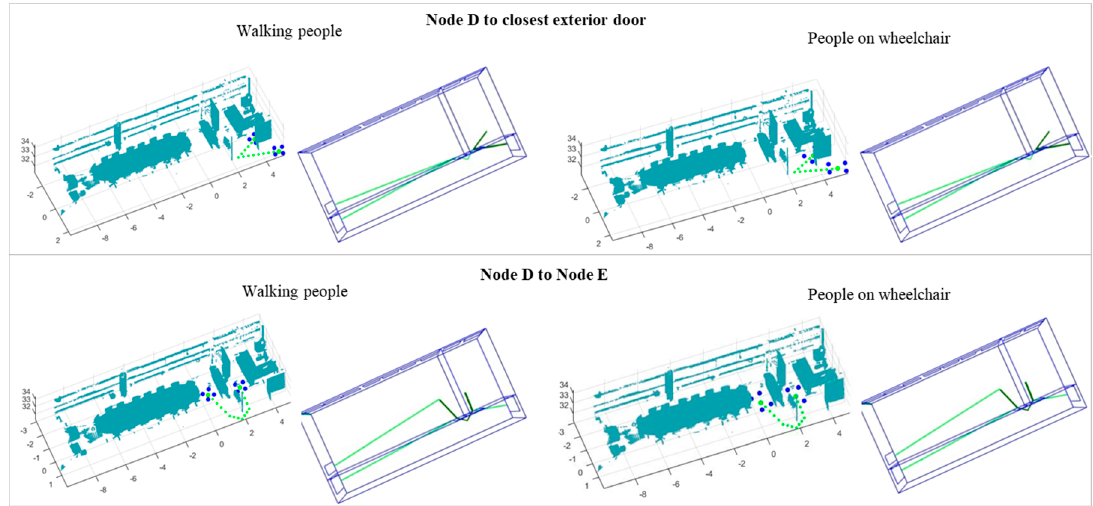
Figure 16. “Node D to closest exterior door” and “Node D to Node E” tests are represented. In these cases, no obstacles were found in the first indoor path; thus, no iterations were needed (units in meters ).